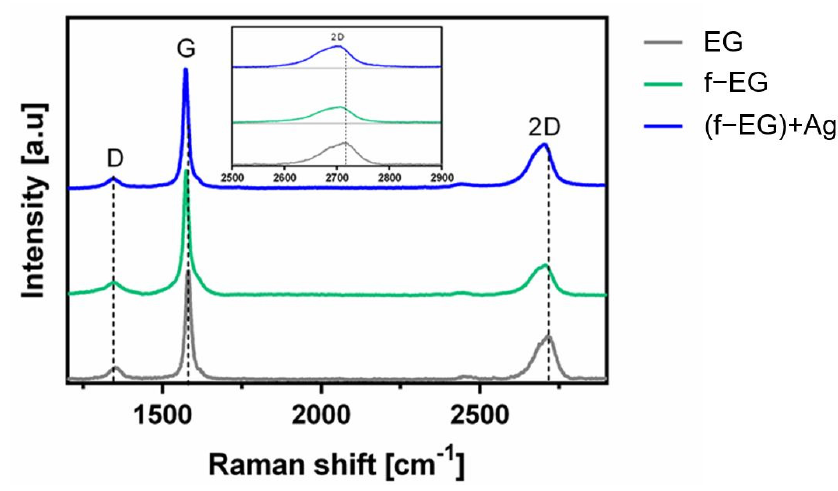
Figure 6. Raman spectra of EG, f-EG, and [(f-EG)+Ag]. The I D /I G ratio is 0.24, 0.10, and 0.13 for EG, f-EG, and [(f-EG)+Ag], respectively.